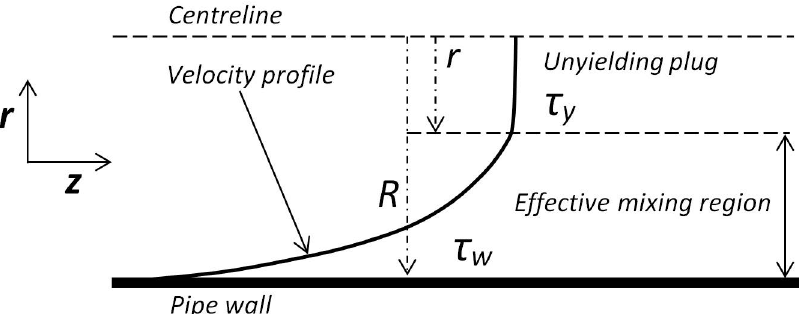
Figure 2. The effective mixing region in a pipe carrying an Herschel–Bulkley fluid with yield stress τ y . The unyielding plug represents the region wherein τ < τ y